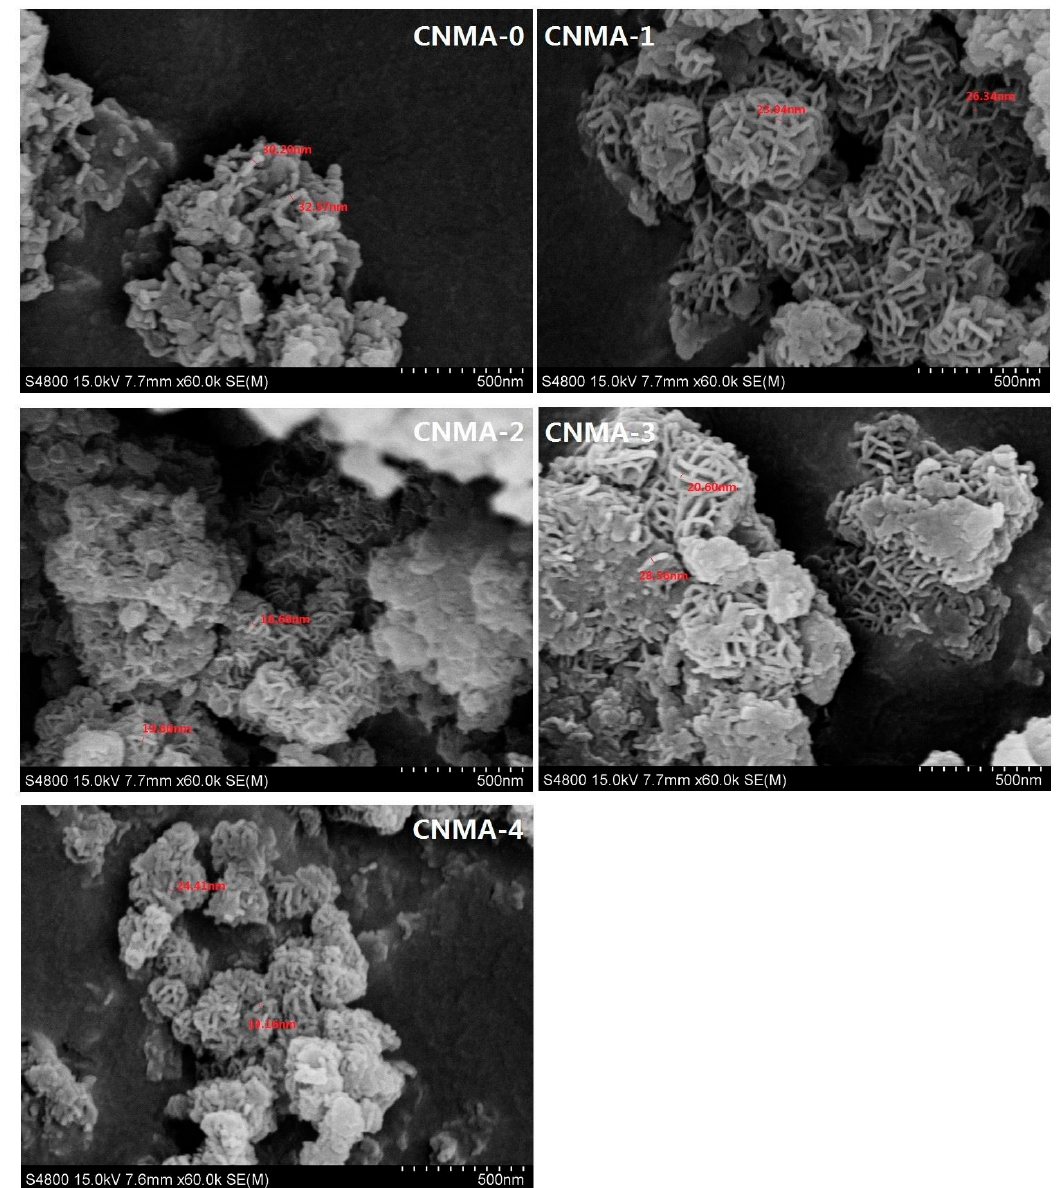
Figure 3. SEM of the hydrotalcite-like precursors with different ratios of Cu:Ni:Mg:Al.